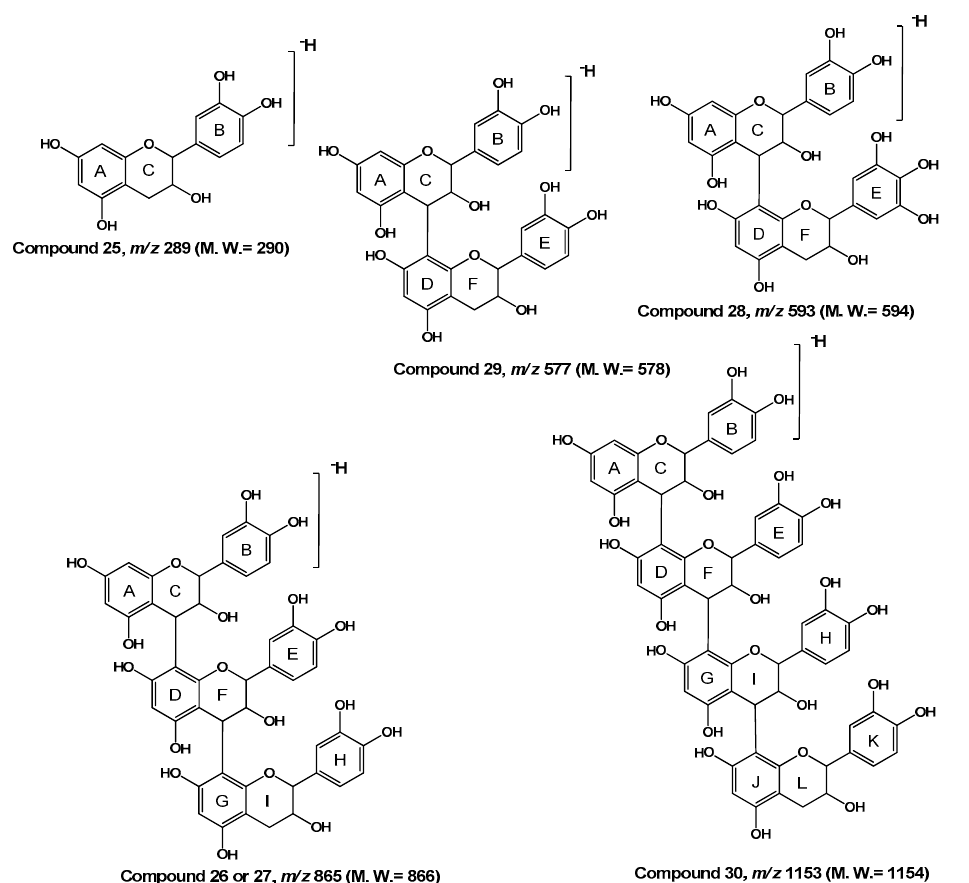
Figure 5. Structure of some phenolic compounds in male flowers of Phoenix dactylifera male flowers.